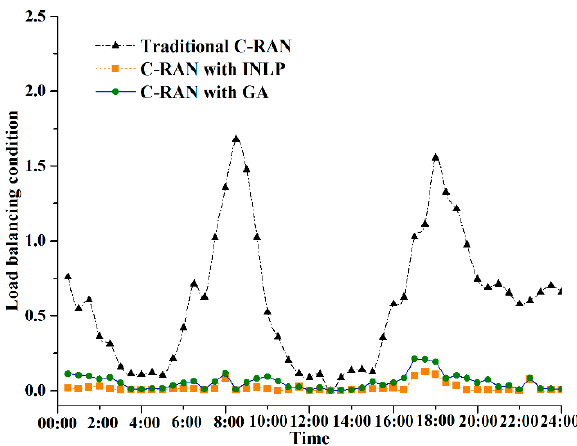
Figure 6. Load balancing conditions with different methods.